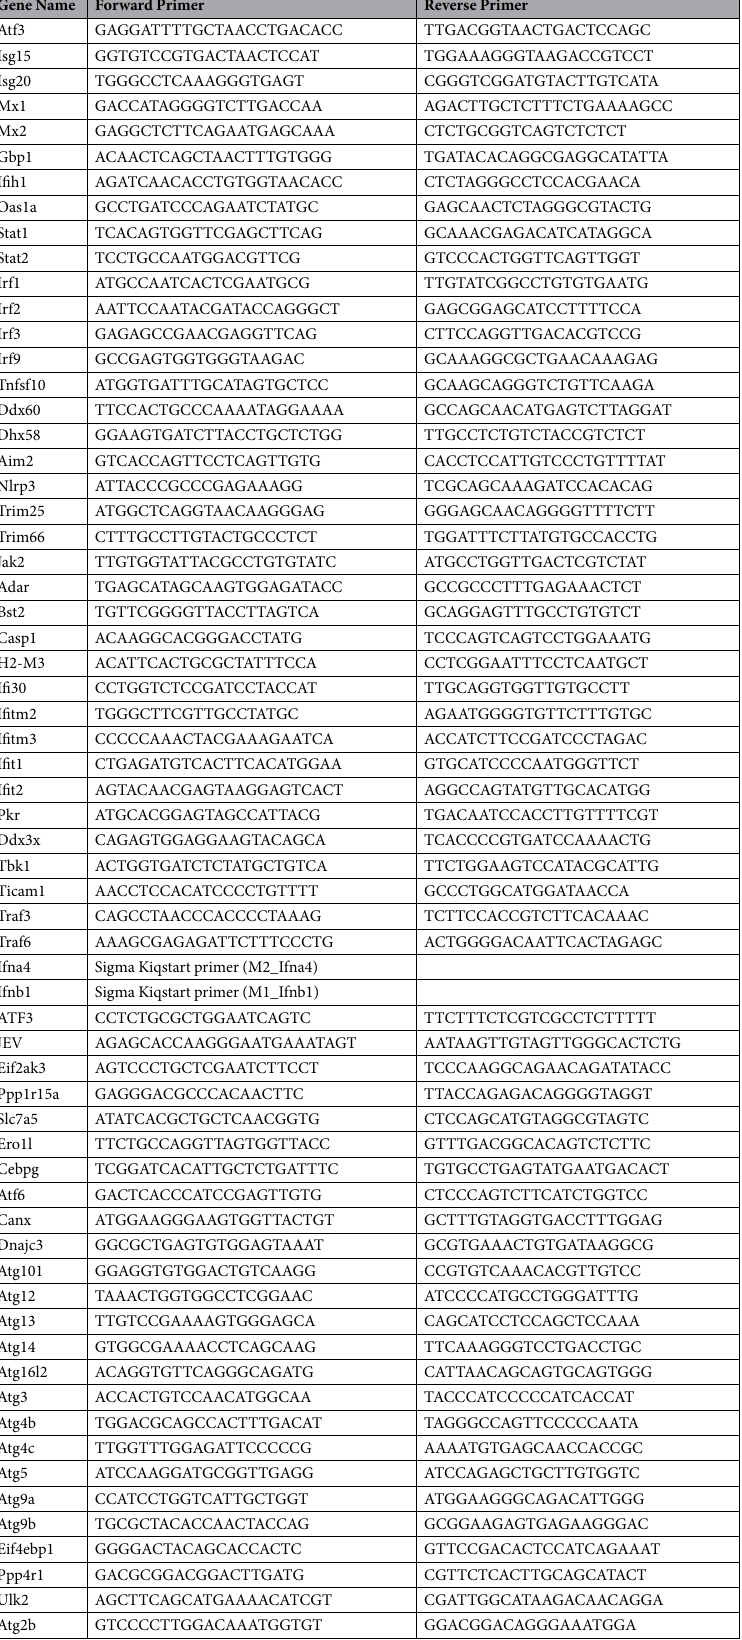
Table 1. Nucleotide sequence of the primers used in the